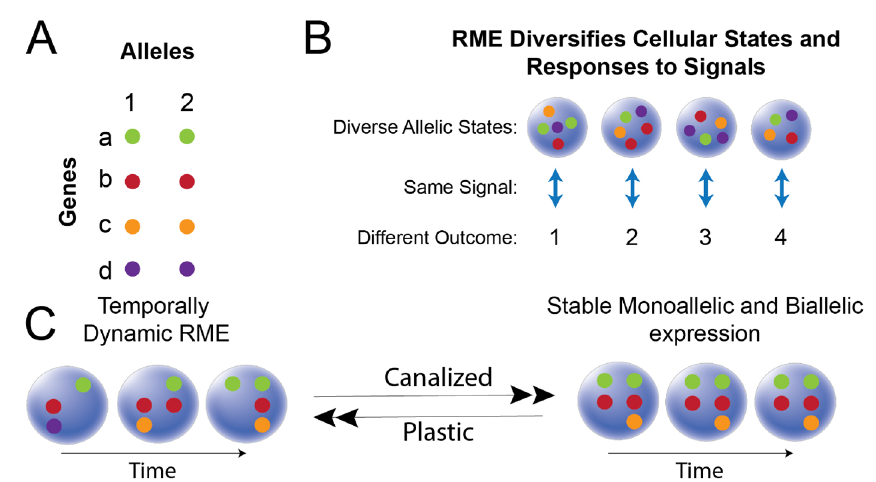
Figure 4. Possible functions for different forms of random monoallelic expression (RME) in promoting cellular diversity and plasticity in mammalian cells. ( A ) Schematic of two alleles (1 and 2) for four genes (a–d). ( B ) A population of four cells is diversified by clonal or dynamic RME such that each cell expresses a different allelic combination. Exposure of the population to a signal in the environment is predicted to result in different outcomes for each cell (1, 2, 3, 4). Some cells will be in a state that responds better (more quickly or correctly) to the signal than other cells. ( C ) Cellular and gene transitions from a temporally dynamic RME state to a stable biallelic or monoallelic (clonal RME or imprinting) state are predicted to shape plasticity versus canalization for gene networks within a cell. The temporally dynamic RME state for different genes is a predicted state of increased plasticity because the cell has access to different allelic combinations that are maintained in a poised state, but these combinations are no longer available once a gene and cell commit to a stable allelic expression